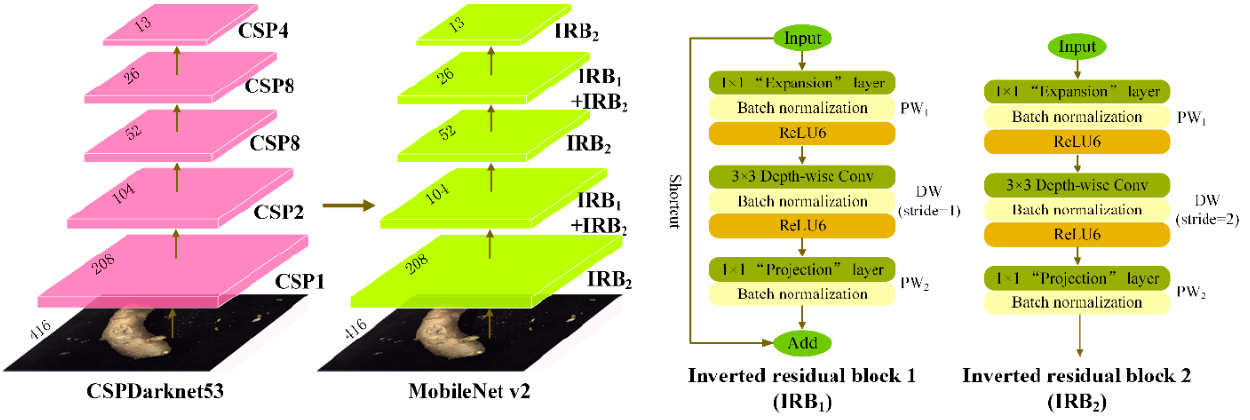
Figure 3. Improved backbone network.